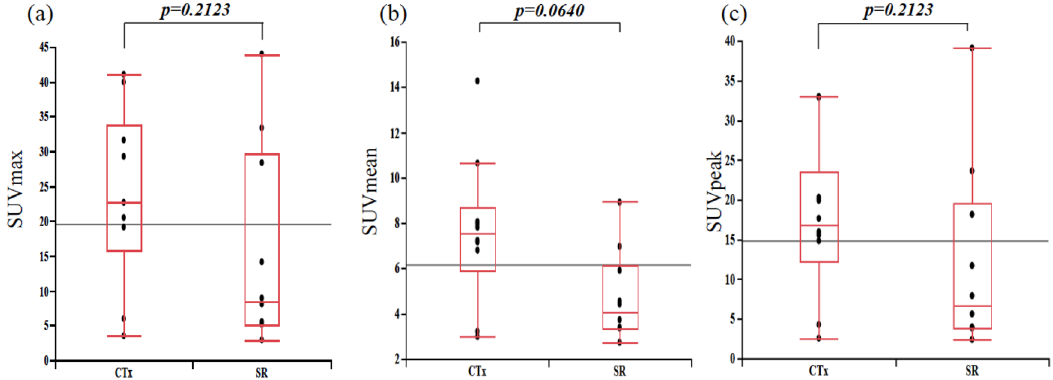
Figure 4. Comparisons of ( a ) SUVmax, ( b ) SUVmean, and ( c ) SUVpeak between SR and CTx